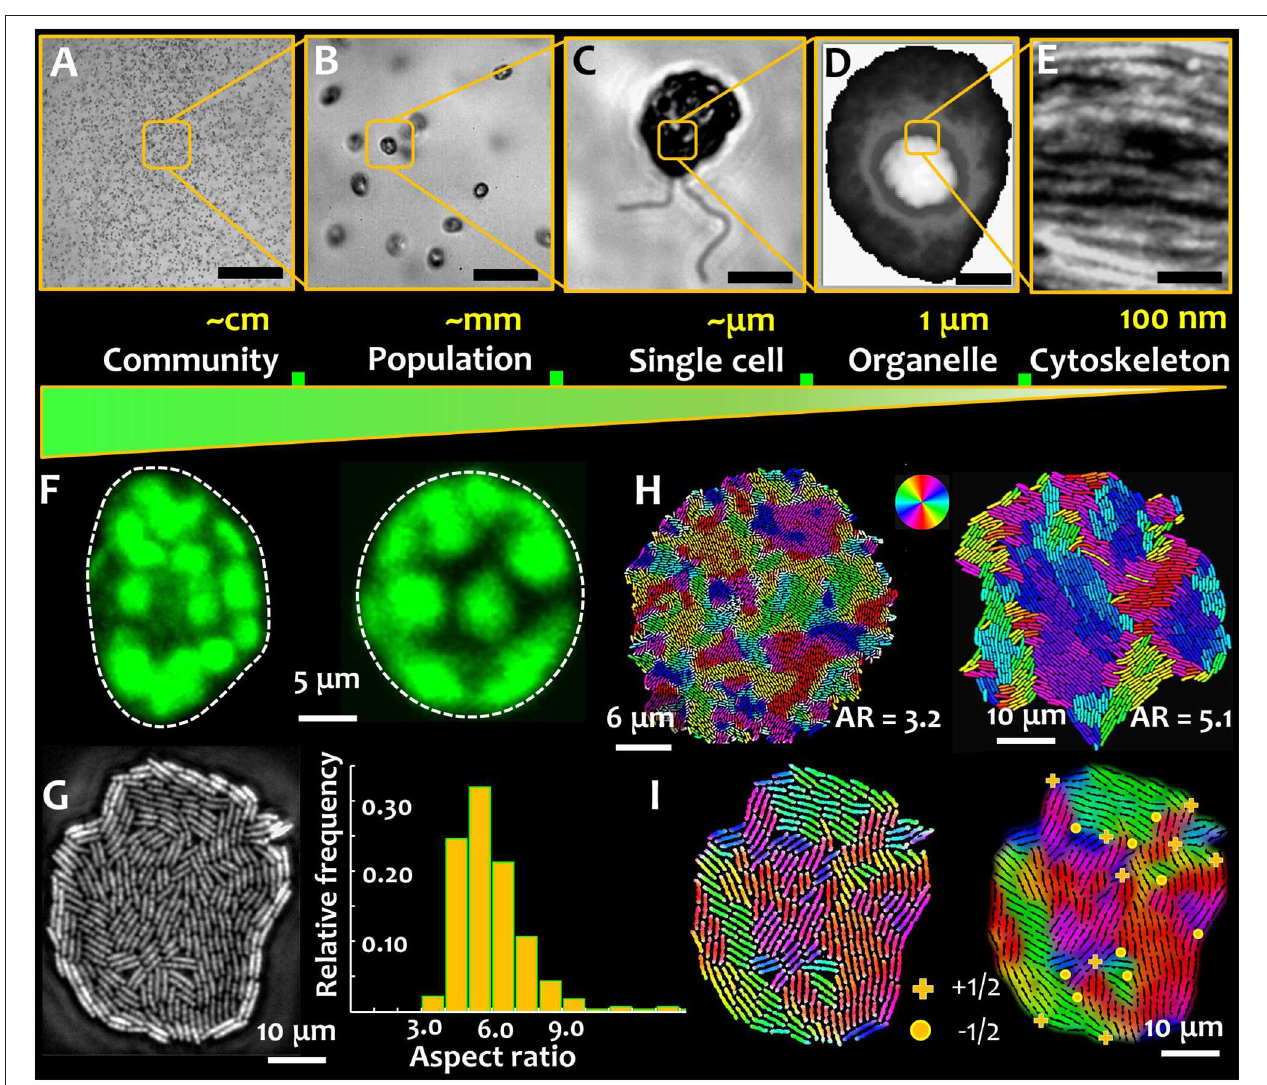
FIGURE 1 | Microbial active matter. Microbial active matter spans multiple scales: from communities comprising populations of multiple species (A) , to microbial populations of single species (B) , down to individual cells (C) Out-of-equilibrium physics underpins biophysical processes at sub-cellular scales, regulating phase separation, organelle compartmentalization, and microbial shape-shifting (D) and directional molecular transport by the cytoskeletal elements (E) . The scale bar in green represents the decreasing system length scales on moving from the microbial community to the cytoskeletal elements. (F) Microbial shape and its modulation are critical determinants of behavior and physiology, shown here for phytoplankton that can carry out rapid morphological transformation from asymmetric (left) to symmetric (right) shape as a response to hydrodynamic cues. Such transformations are mediated by the active reorganization of the cytoskeleton. Chloroplasts surrounding the cell membrane of photosynthetic phytoplankton species appear as blobs (false colored in green), imaged here using chlorophyll autofluorescence. (G) Microbial shape in a monoclonal culture can be intrinsically heterogeneous, as captured in an expanding colony of rod shaped bacteria. The growth conditions play a key role in tuning the aspect ratio of cells, a metric of microbial shape. (H) Cell aspect ratio determines the size of self-organized nematic microdomains in a growing bacterial colony. The colors denote local cell orientations, as per scheme shown in the color wheel. (I) Topological defects in an expanding bacterial colony. ( + ) sign indicates + 1/2 integer defects and (•) indicates − 1/2 topological defects, which appear at the intersection of nematic microdomains. ( D,H are adapted from the author’s work [1, 2], and E from Jin et al. [3], with permissions from the Nature Publishing Group, Creative Commons CCBY license and John Wiley and Sons,